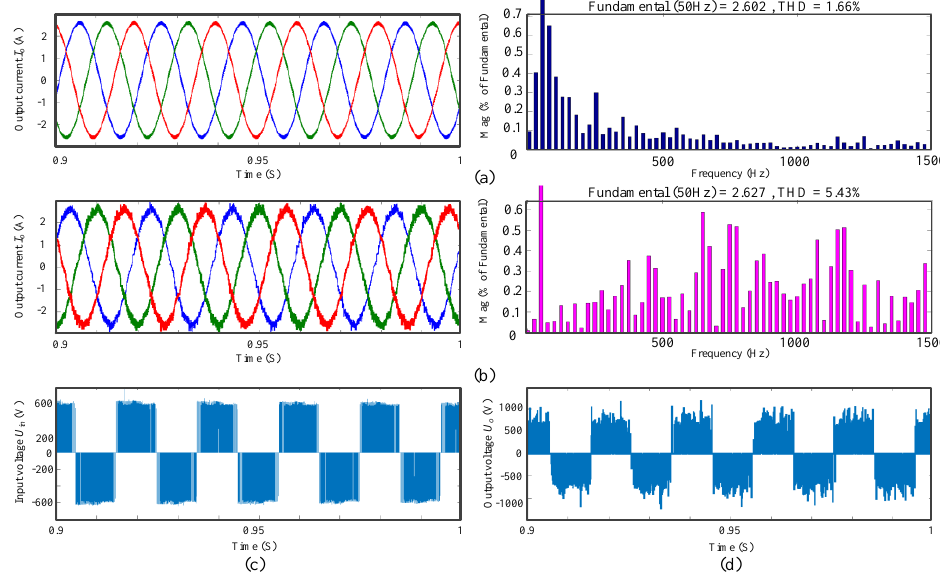
Figure 10. Output current and voltage with abnormal supply under rated condition ( a ) output current and its total harmonic distortion (THD) with proposed method; ( b ) output current and its THD with conventional method; ( c ) output voltage with proposed method; ( d ) output voltage with conventional method.